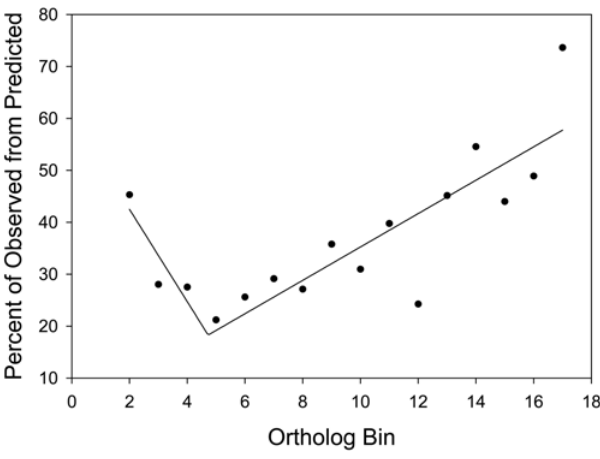
Figure 1. The relationship between the number of bacteria and the percent of observed proteins from predicted orthologs. The number of predicted orthologs represents the sum of orthologs identified in- silico from any combination of bacteria within the set. As the number of organisms increased from 5 to 17, proteomes among the individual bacteria converged to a set of conserved proteins, or core proteome.